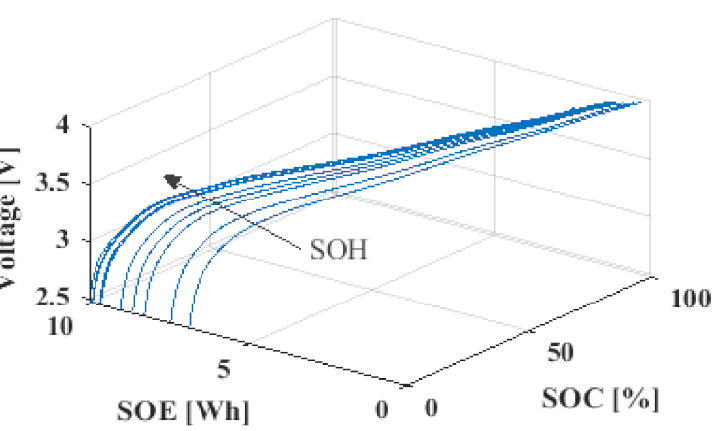
Figure 7. Characterization of the SOH based on the cell voltage and SOC, and SOE at ambient